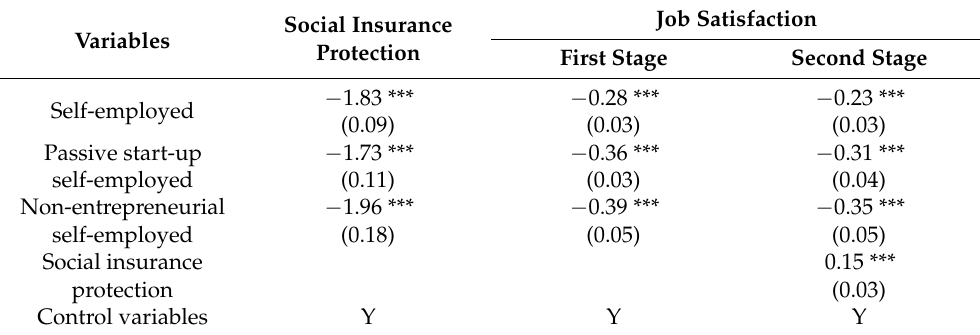
Table 8. OLS regression results of self-employment’s impact on job satisfaction mediated by social